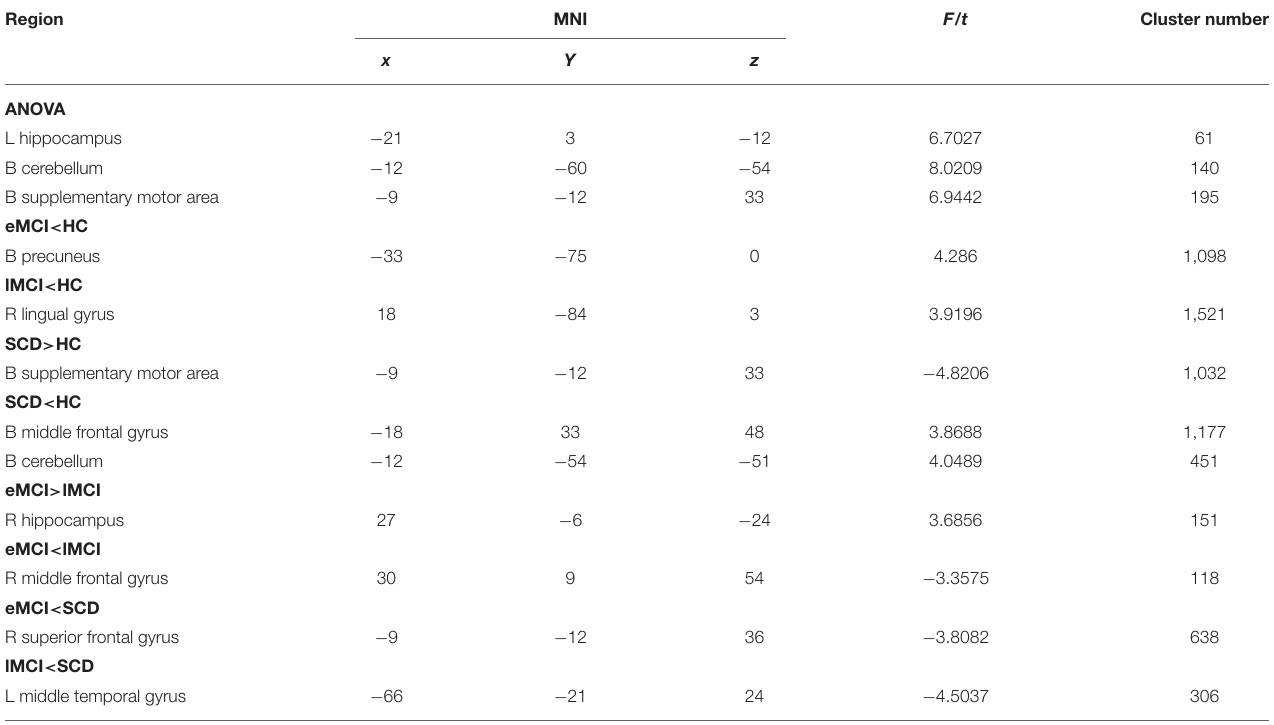
TABLE 2 | Regions of BNM-FC based on analysis of variance (ANOVA) analysis and two-sample t -tests. Region MNI F / t Cluster